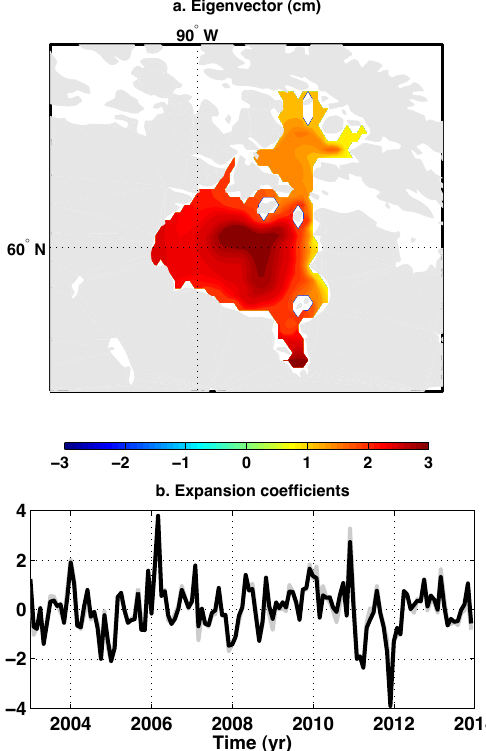
Figure 8. As in Fig. 4 but shown for the experiment driven only by wind stress over regions of statistically significant correlation coefficients shown in Fig. 6. In (b) , the nonseasonal time series of the leading expansion coefficients from the baseline experiment is shown in gray for